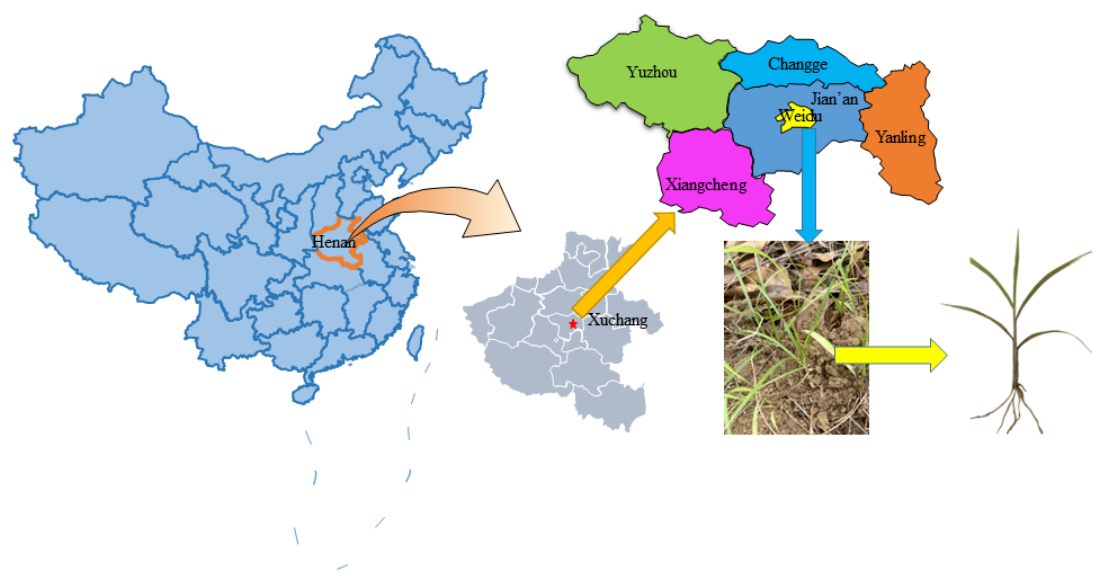
Figure 1. Study area and sampling location.